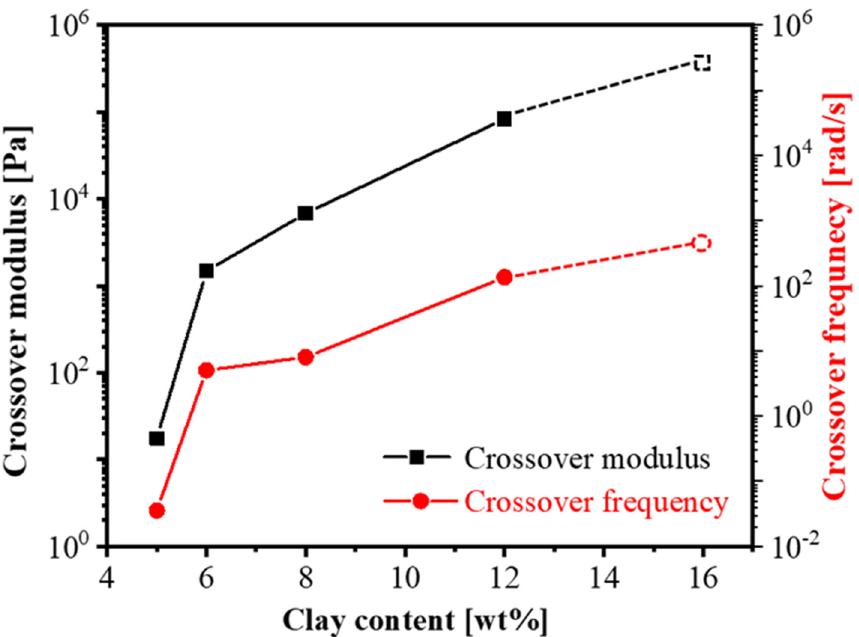
Figure 2. Crossover modulus and frequencies of HTPB28/C18-clay (5–16 wt%) nanocomposites in TTS. The sample with a 16 wt% concentration does not have a clear intersection point within the test temperature range, so the maximal values of storage modulus and frequency obtained from the experiment are used as substitutes and displayed in the form of dotted points.